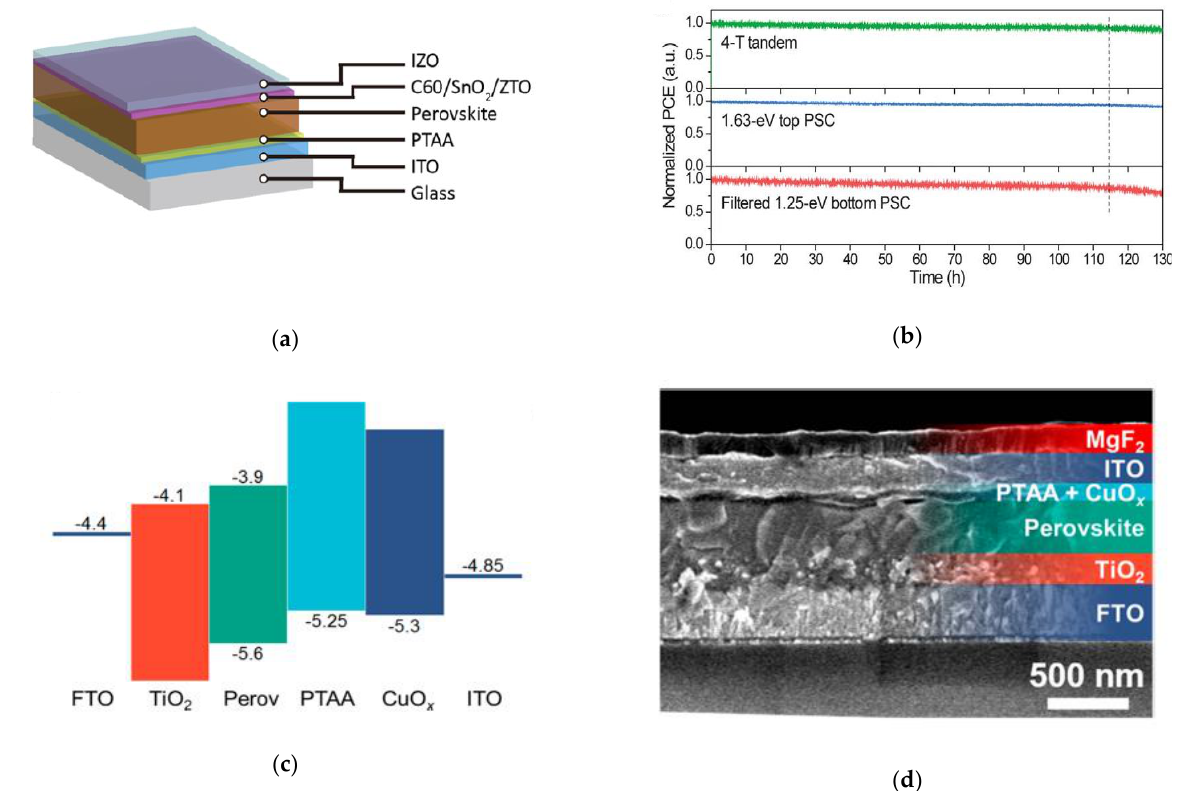
Figure 7. Incorporation of ALD SnO x and zinc tin oxide (ZTO) in perovskite tandem devices: ( a ) Device stack configuration of the top perovskite cell; ( b ) Normalized PCE as a function of time for the various PSC devices. Reproduced from [59], with permission from the American Association for the Advancement of Science, 2019. Incorporation of atmospheric-pressure chemical vapor deposition (AP-CVD) of CuO x as a buffer layer in semitransparent PSC: ( c ) Schematic of band alignment of the device; ( d ) Cross-sectional SEM image of the device stack. Reproduced from [64], with permission from the American Chemical Society, 2020.